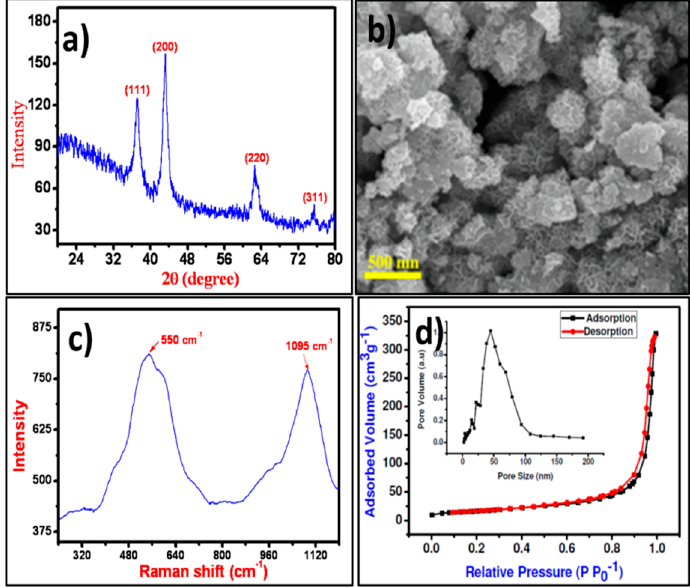
Figure 1. ( a ) XRD pattern, ( b ) FE ‒ SEM image, ( c ) Raman spectrum, and ( d ) N 2 adsorption ‒ desorption plots (with pore ‒ size distribution as inset) of NiO NPs.